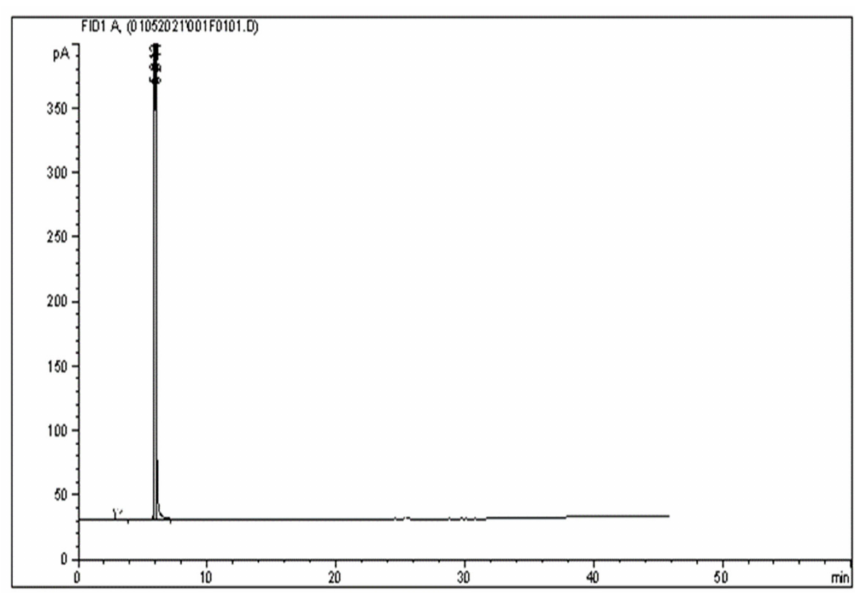
Figure 1. GC chromatogram of 1 µ L of diluent (hexane) injected into the system.